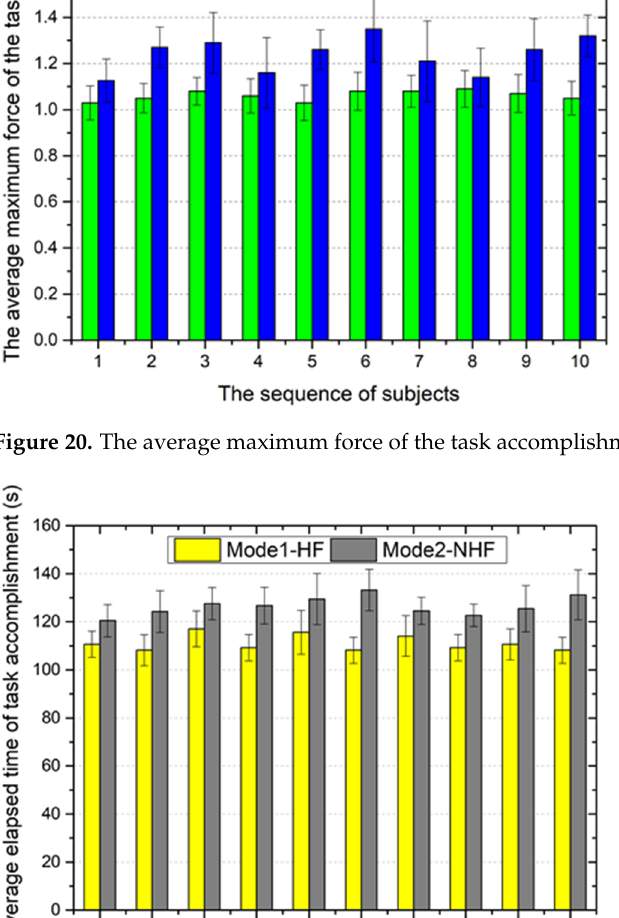
Figure 21. The average elapsed time of task accomplishment.